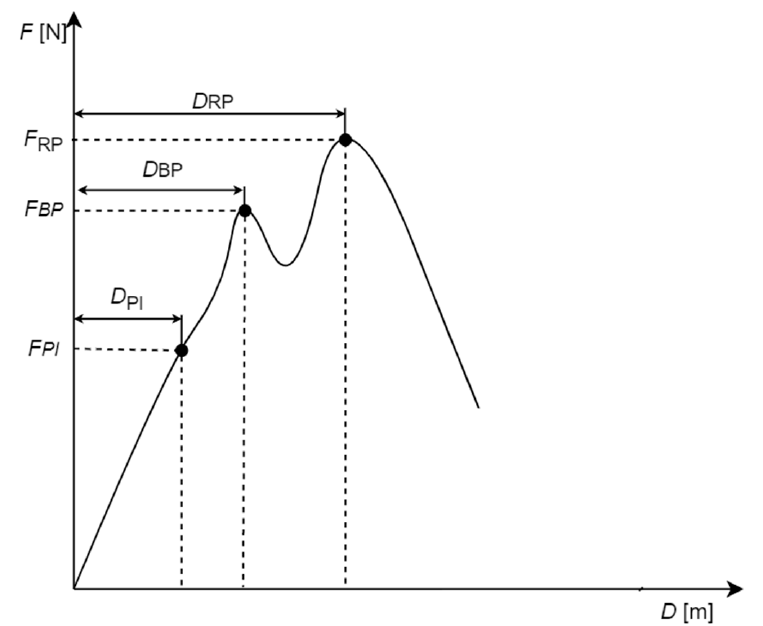
Figure 3. Characteristic points determined on the force-deformation curve obtained from the corn grain compression test.